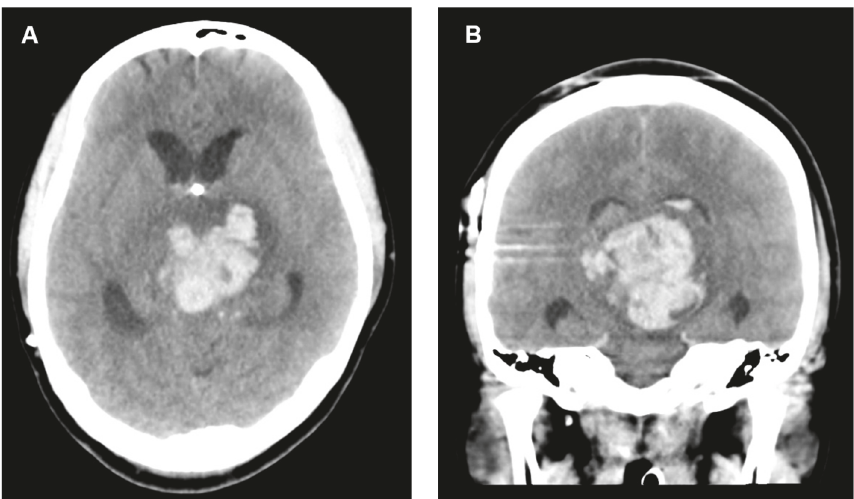
Figure 4: The emergency head CT on postpartum day 2 revealed cerebral herniation due to massive intratumoral hemorrhage ((A); axial view, (B); coronal